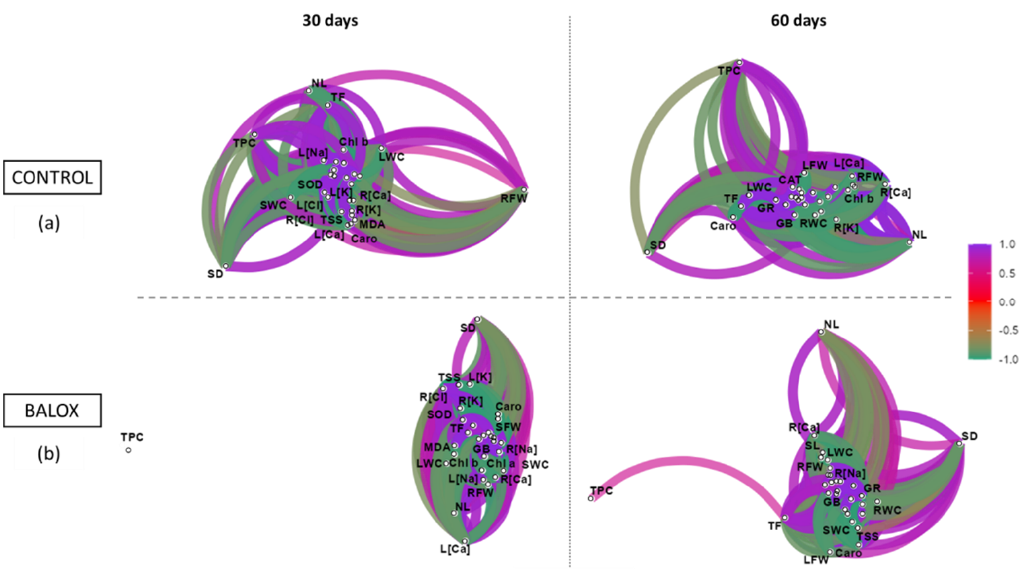
Figure 12. Correlation network plot showing the significant correlations ( p < 0.05) between the 30 traits measured in each period (30 days: vegetative development; 60 days: onset of reproductive development) in the control ( a ) and plants treated with the biostimulant containing polyphenols at 1.4% ( w / w ) and glycine betaine at 3.0% ( w / w ) at a dose of 0.4 mL L − 1 of irrigation water ( b ), according to Pearson’s correlation coefficients. Each measured trait represents a node, and highly correlated traits are grouped. Only significant correlations are represented. Each path represents a correlation between the two variables it links. The purple path represents a positive correlation, and the green path represents a negative correlation. The width and transparency of the line represent the strength of the correlation, so the thicker and more intense the line, the stronger the correlation. Abbreviations: SL: stem length; SD: stem diameter; NL: number of leaves; RFW: root fresh weight; SFW: stem fresh weight; LFW: leaf fresh weight; RWC: root water content; SWC: stem water content; LWC: leaf water content; Chl. a: chlorophyll a; Chl. b, chlorophyll b; Caro, total carotenoids; R [Ca], root calcium; L [Ca], leaf calcium; R [K], root potassium; L [K], leaf potassium; R [Na], root sodium; L [Na], leaf sodium; R [Cl], root chloride; leaf chloride, L [Cl]; Pro, proline; GB, glycine betaine; TSS, total sugars; MDA, malondialdehyde; H 2 O 2 , hydrogen peroxide; SOD, superoxide dismutase; CAT, catalase; GR, glutathione reductase; TPC, total phenolic compounds; and TF, total